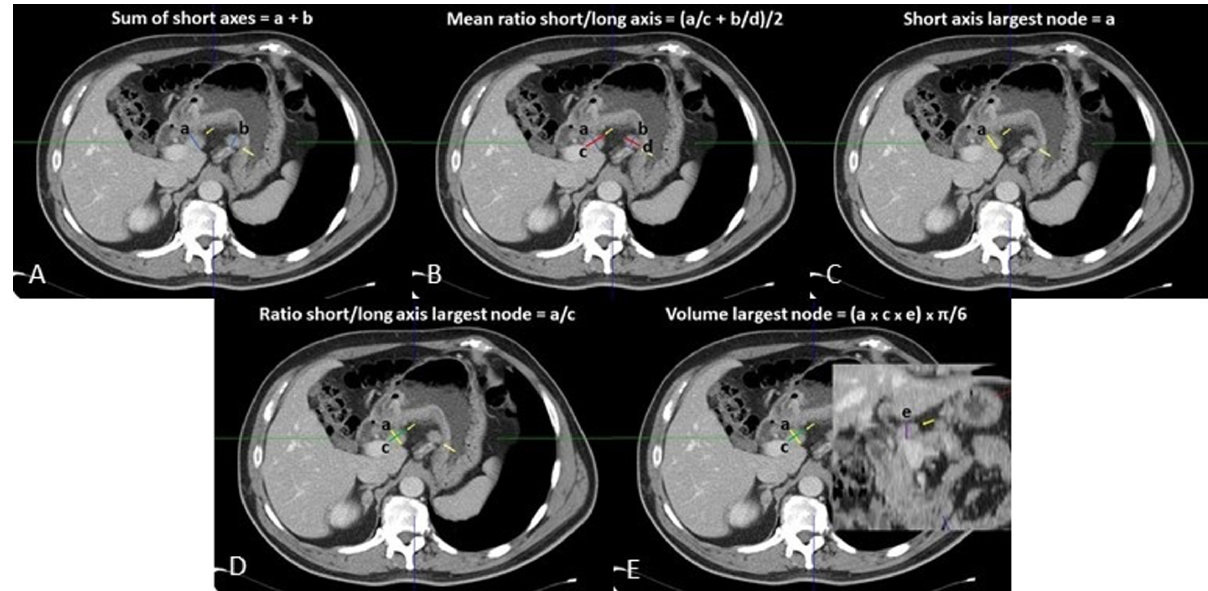
Figure 1. Loco-regional CT measurements: ( A ) sum of short axes; ( B ) mean of ratios of short/long axes; ( C ) short axis of largest lymph node; ( D ) ratio of short/long axis of largest lymph node; ( E ) volume of largest lymph node.